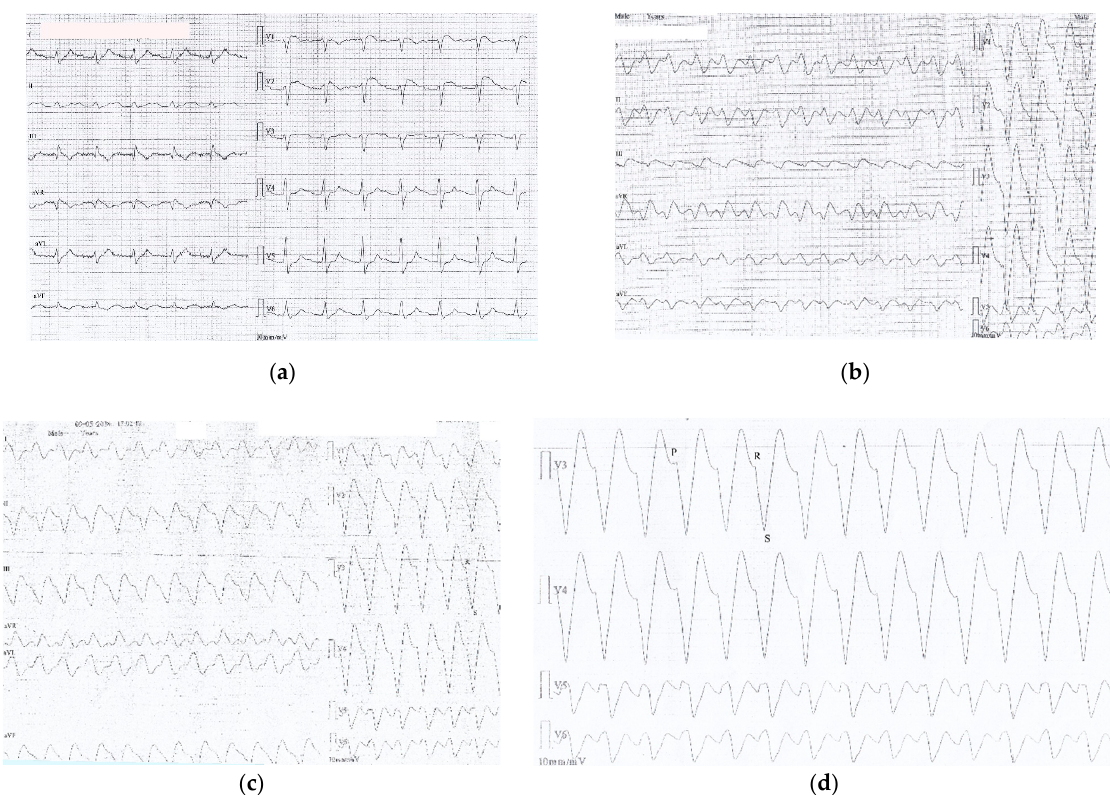
Figure 2. ( a ) ECG recorded one hour after ED admission (6 h after drugs ingestion): sinus rhythm 67/min, prolonged PR